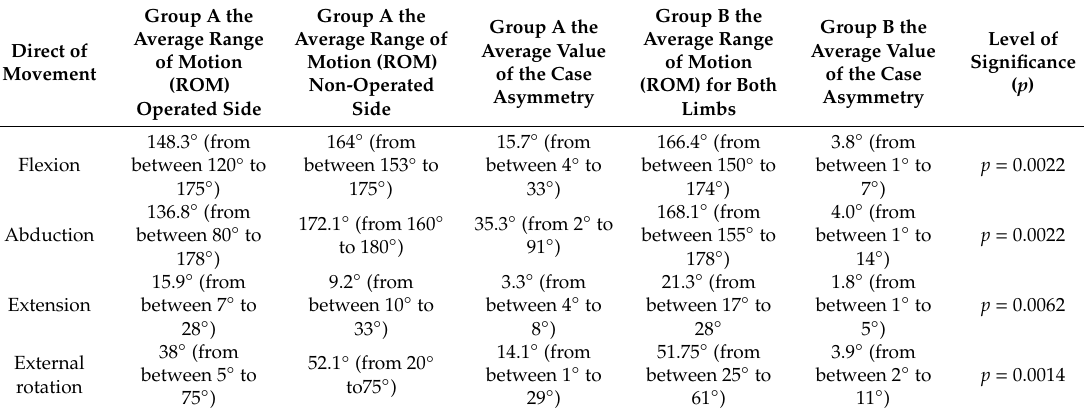
Table 3. Shoulder active mobility